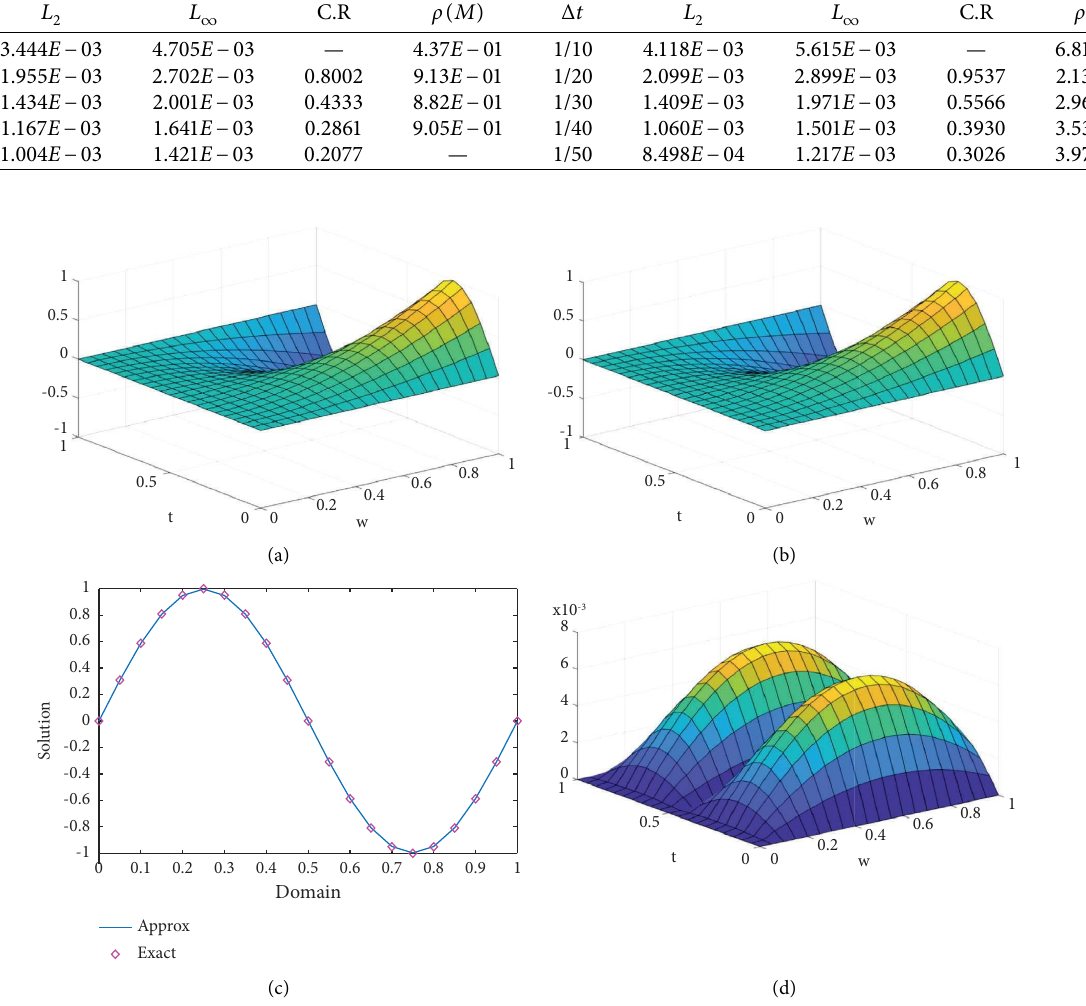
Figure 3: Graphical solution of approximate, exact, and error of Y at h � Δ t � 0 . 05 and plot at t � 1. (a) Approximate solution. (b) Exact solution. (c) Approximate vs Exact. (d) Error.